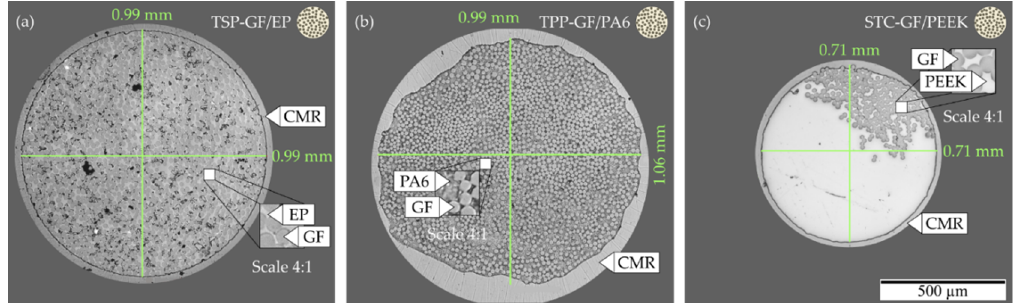
Figure 9. Photomicrographs of investigated specimens made of glass fibre (GF) reinforced polymers manufactured by means of thermoset pultrusion (TSP) and thermoplastic pultrusion (TPP) embedded in cold mounting resins (CMR): ( a ) GF / epoxy resin (EP), D = 0.98 mm; ( b ) GF / polyamide (PA)6; D = 1.02 mm; ( c ) GF / polyether ether ketone (PEEK), D = 0.67 mm.